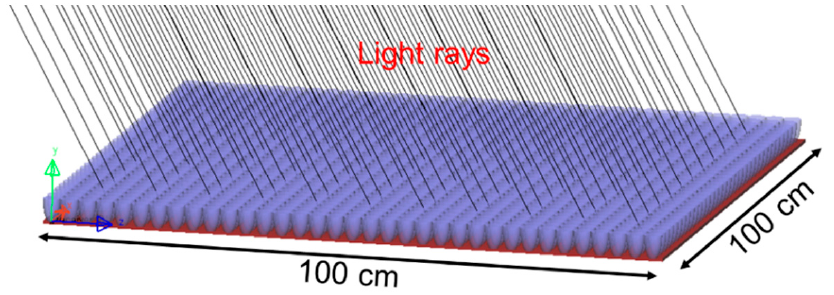
Figure 5. A ray-tracing simulation setup for the solid CPC module under different incidence angles.